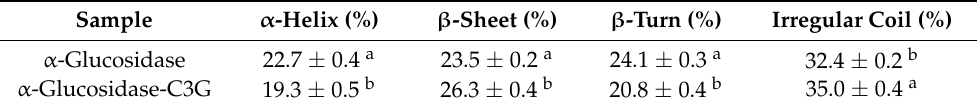
Figure 7. The profiles of α‐ glucosidase (20 μ M) secondary structure treated by 50 μ M C3G. Table 4. Secondary structure analysis of α‐ glucosidase and its complex with C3G. Table 4. Secondary structure analysis of α -glucosidase and its complex with